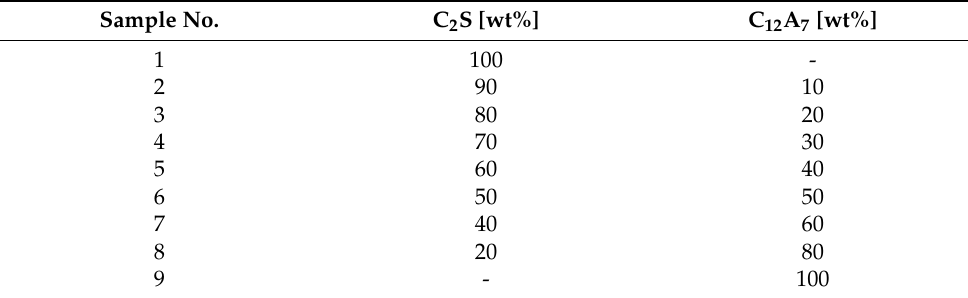
Table 1. Composition of batches for sinter preparation.